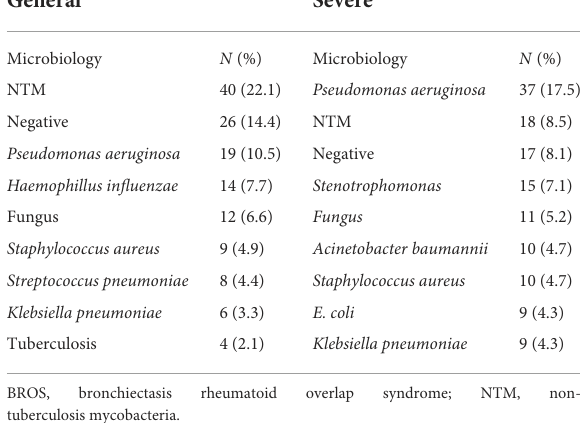
TABLE 3 Characteristics and outcomes of BROS grouped with diagnosis